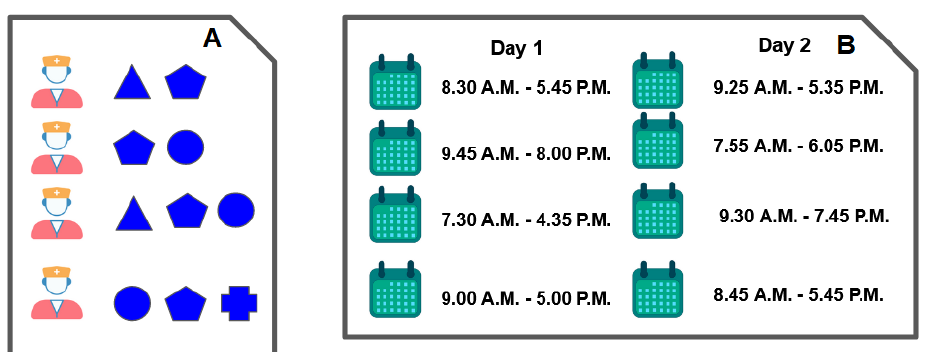
Figure 4. Caregiver qualifications’ table ( A ); starting and ending working hours for each caregiver on a two-day basis ( B ).